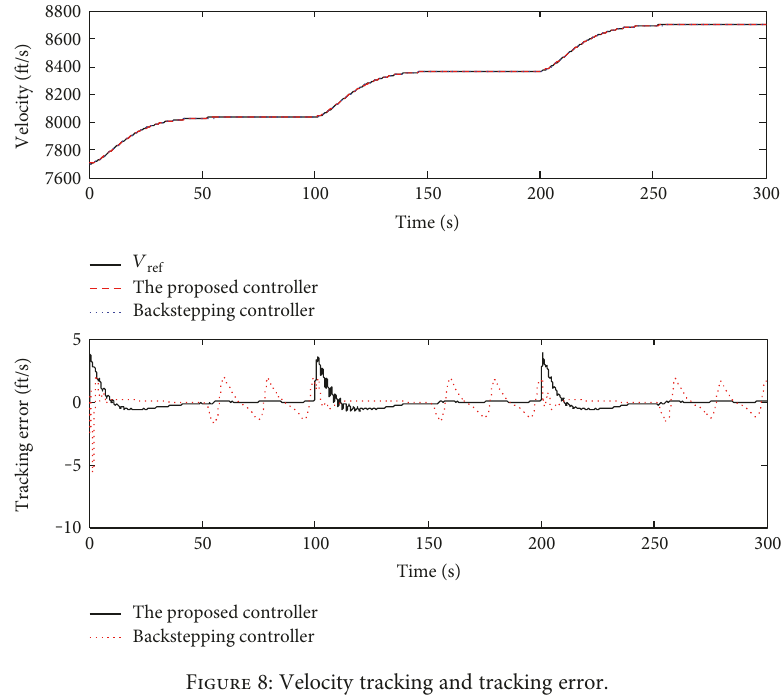
Figure 8: Velocity tracking and tracking error.